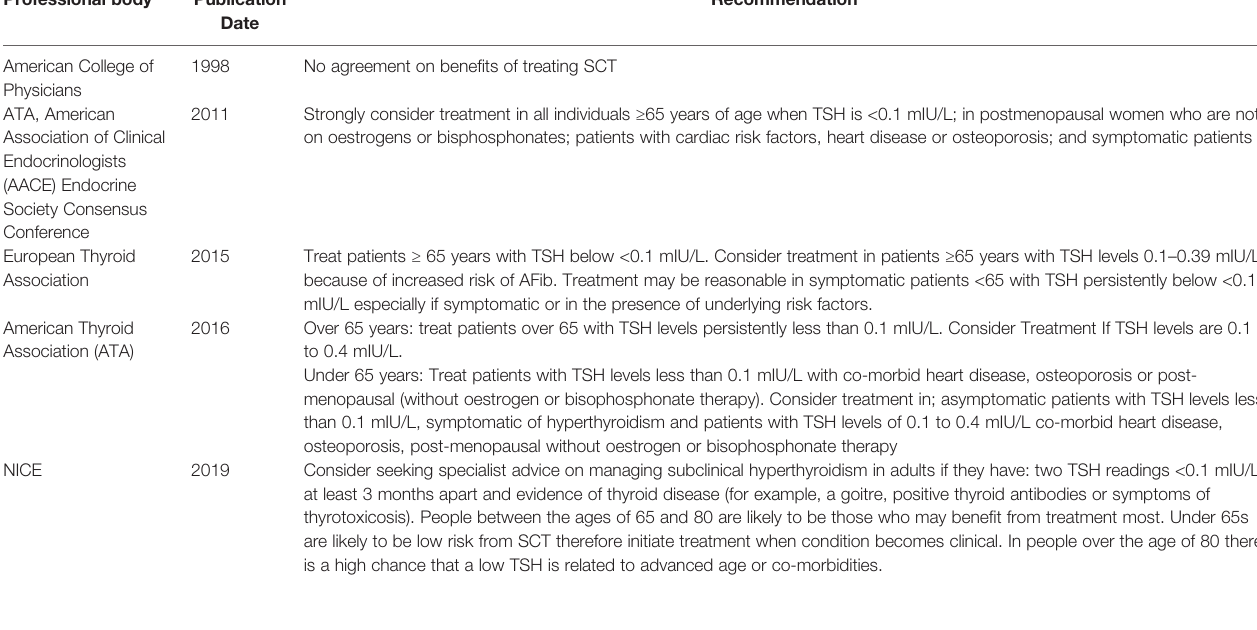
TABLE 1 | Synopsis of SCT treatment guidelines produced by professional